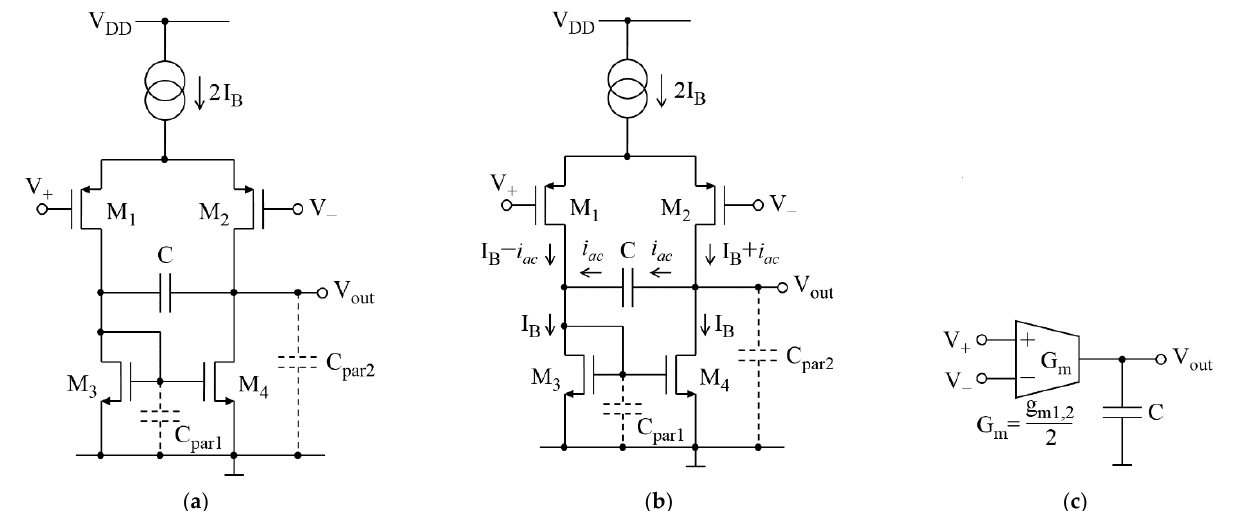
Figure 3. Proposed lossless integrator: ( a ) transistor-level circuit; ( b ) the flow of currents under conditions C par 1 << C , C par 2 << C , and C par 1 ≥ C par 2 ; ( c ) equivalent OTA-C (Gm-C) diagram. The transconductance g m 1,2 means g m 1,2 = g m 1 = g m 2 .